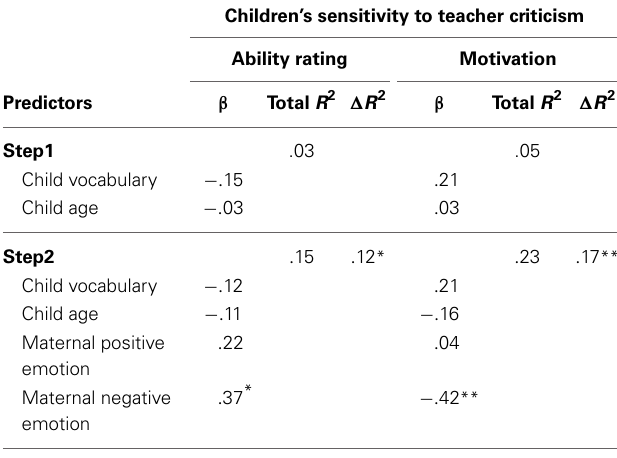
Table 2 | Mothers’ reported emotional expressiveness in mother–child interactions as a predictor of children’s sensitivity to teacher